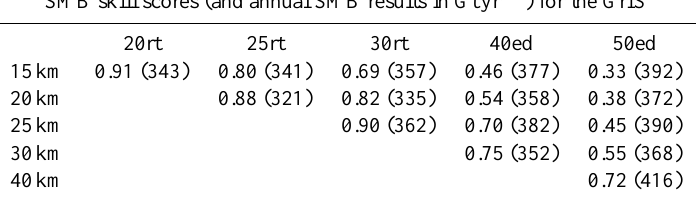
Table 5. Summary of the main skill scores and annual GrIS SMB results (in brackets) of MAR simulations (e.g. 20rt) interpolated onto higher-resolution GrIS mask (e.g. 15km) and corrected with daily vertical gradients, for the 1990–2010 period. SMB skill scores (and annual SMB results in Gtyr − 1 ) for the GrIS